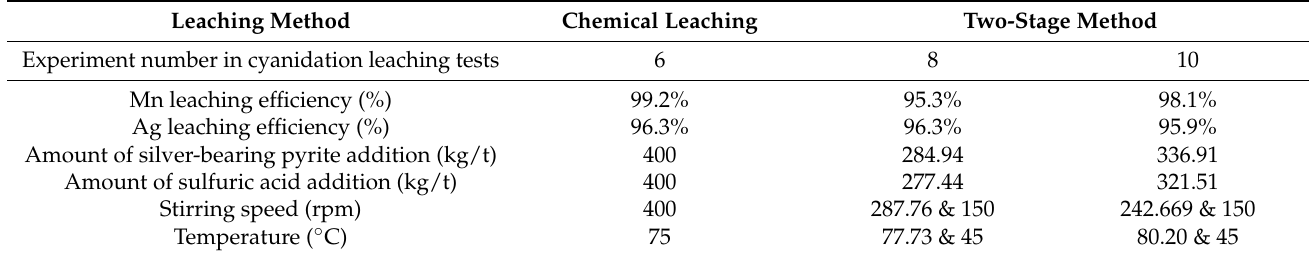
Table 8. Comparison of chemical leaching and two-stage